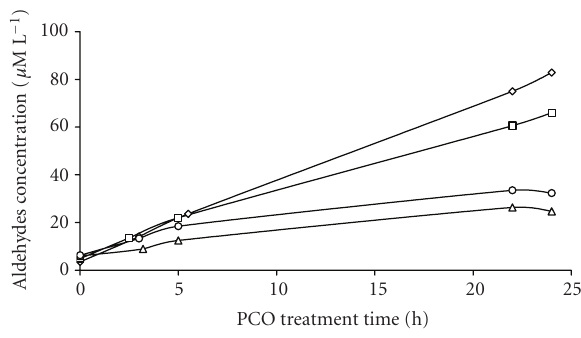
Figure 6: The dependence of PCO e ffi ciency of lignin on the ferrous ion concentration: initial concentration of lignin 100 mg L − 1 , pH 3; plate 0.75 mg cm − 2 (spaying) ( (cid:3) ), plate 0.7mg cm − 2 (submersion) ( (cid:2) ), plate 0.3 mg cm − 2 (submersion) ( (cid:3)